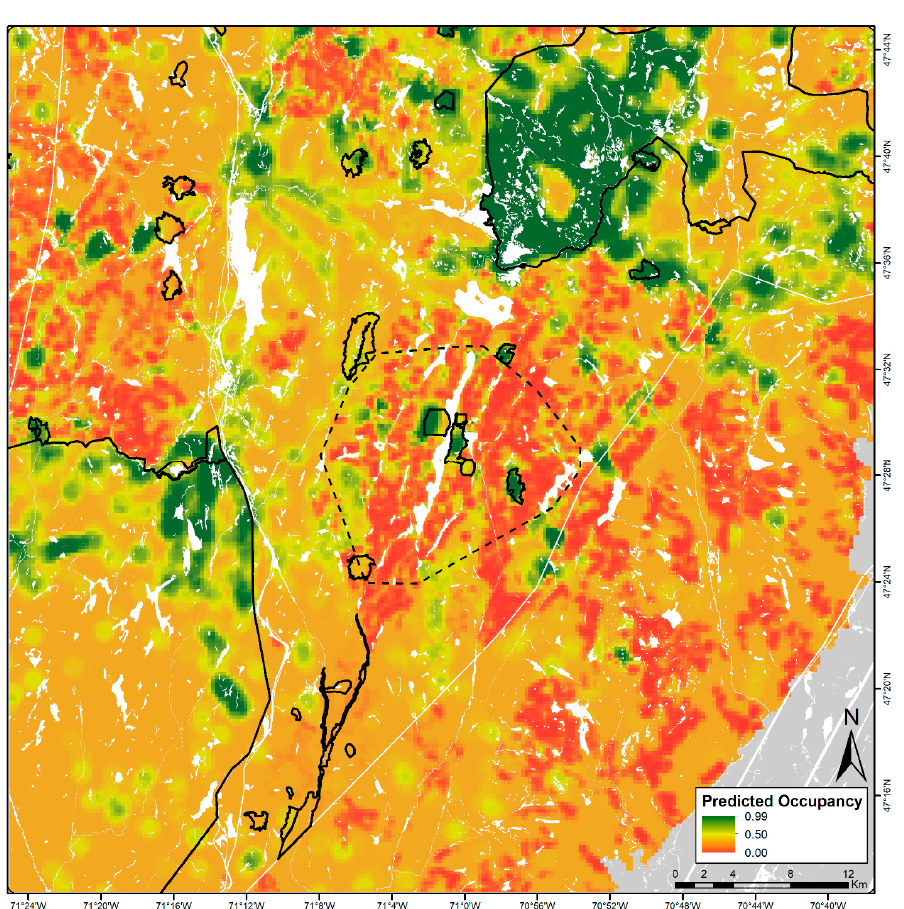
Figure 3. Predicted probability of occupancy of American Three-toed Woodpecker at the regional scale within the balsam fir–white birch bioclimatic domain. Probability of occupancy is inferred from the top-ranking models ( Δ AIC c < 2; Table 2). The dashed and solid black lines respectively delineate the boundaries of the study area and protected areas and white polygons indicate non-forested lands.